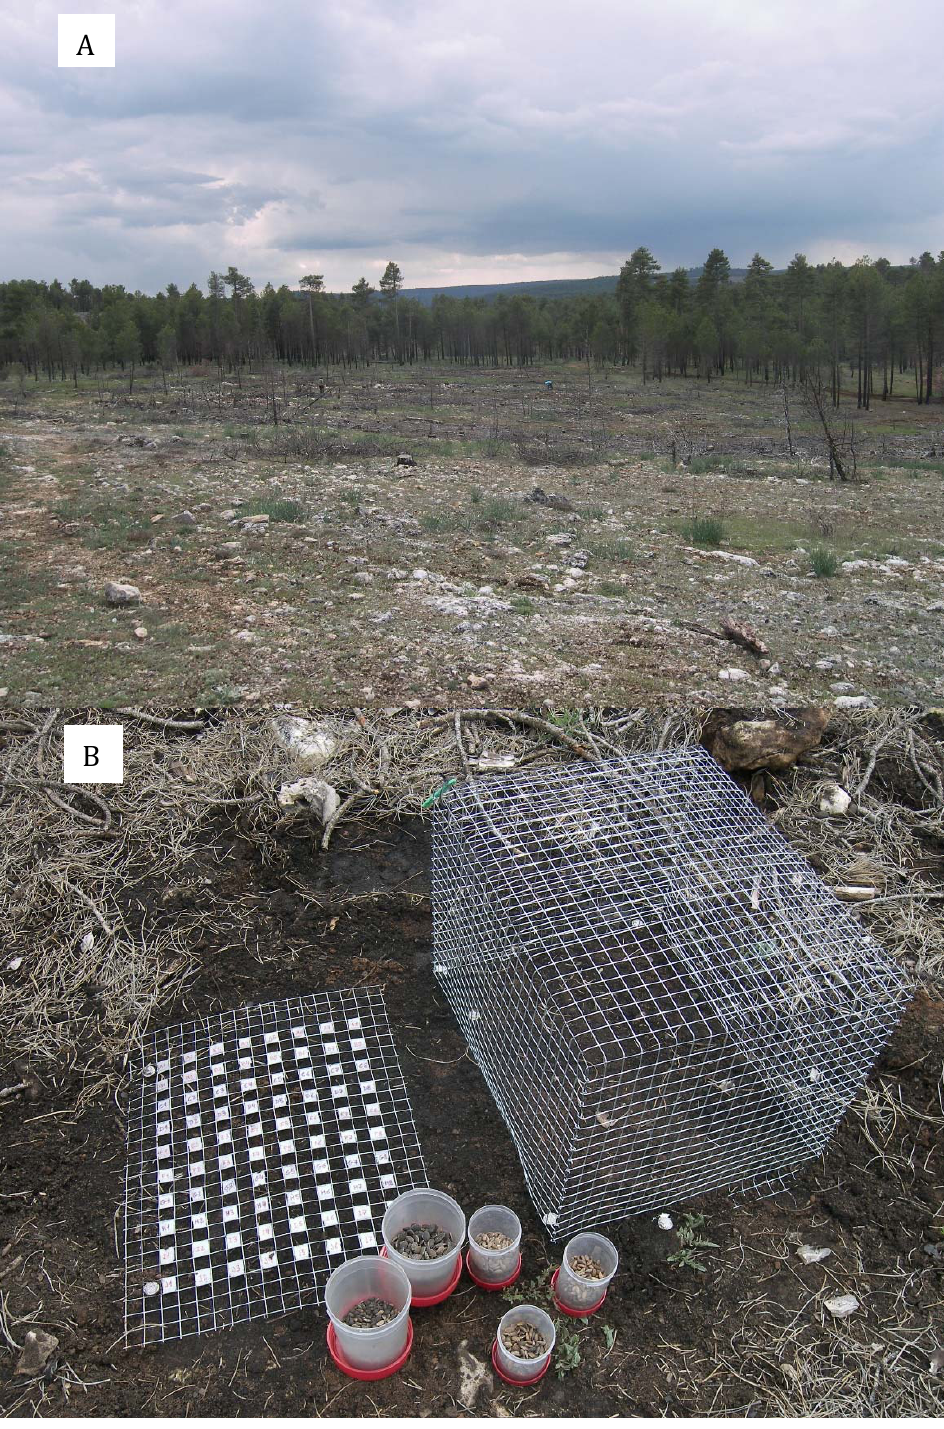
Figure 1. General view of the totally burned area without canopy cover ( A ) and a sowing point example in the totally burned area at the beginning of the experiment in April 2011 ( B ).